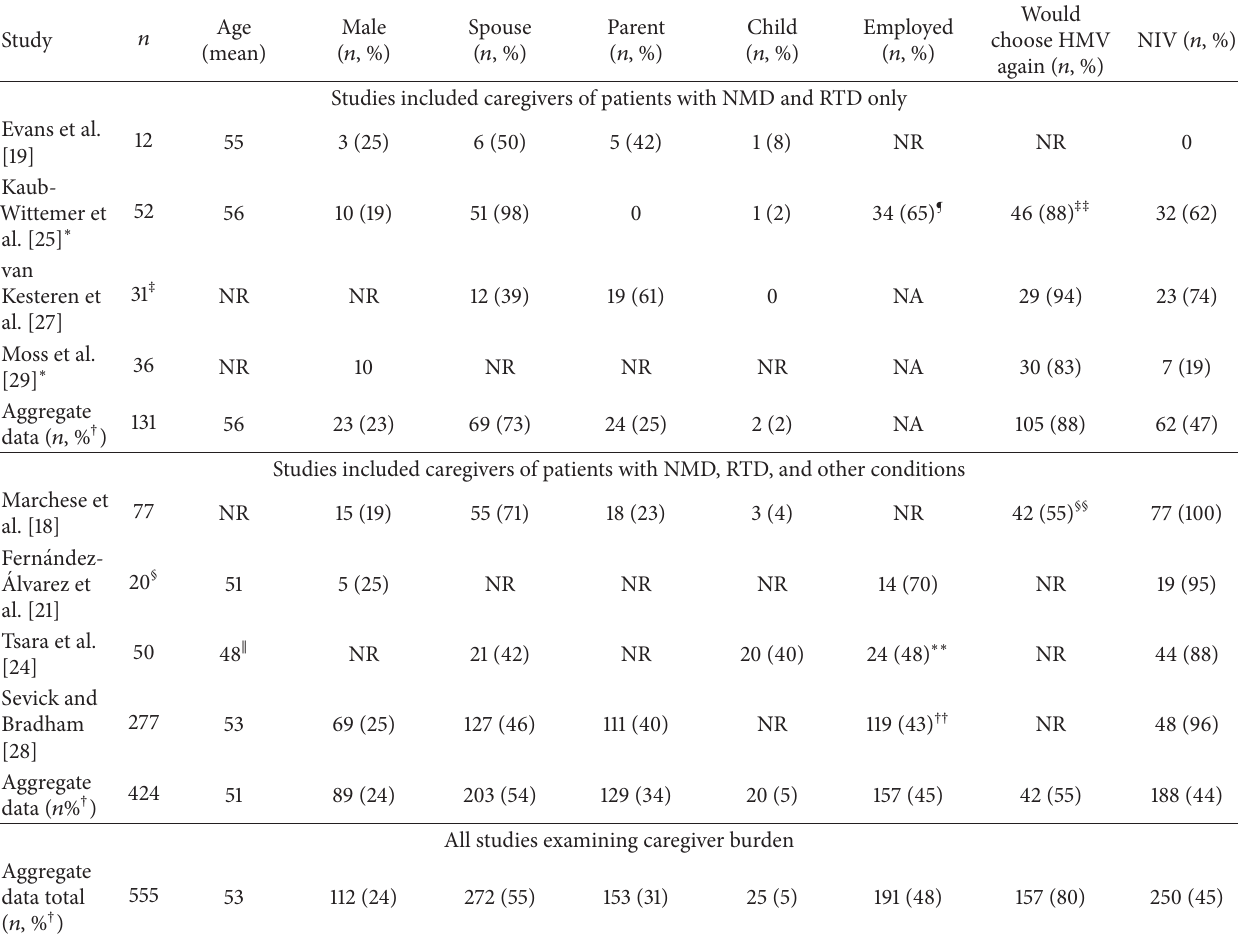
Table 5: Primary caregiver